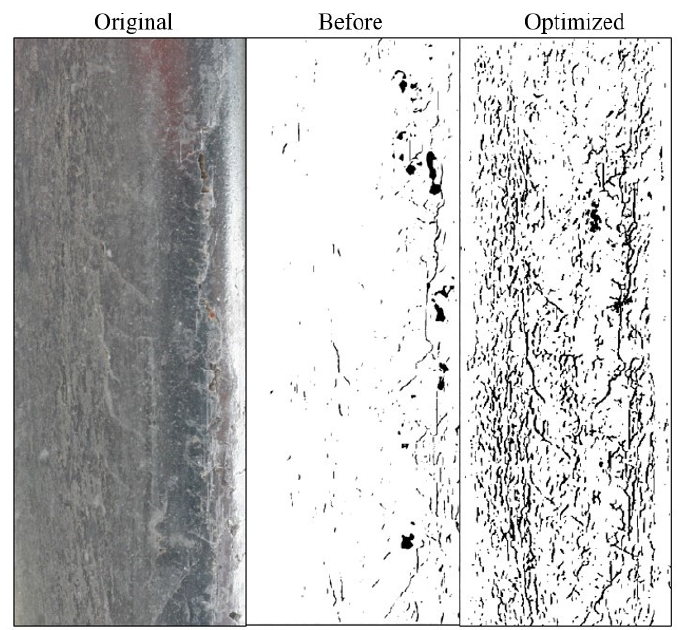
Figure 6. Optimized